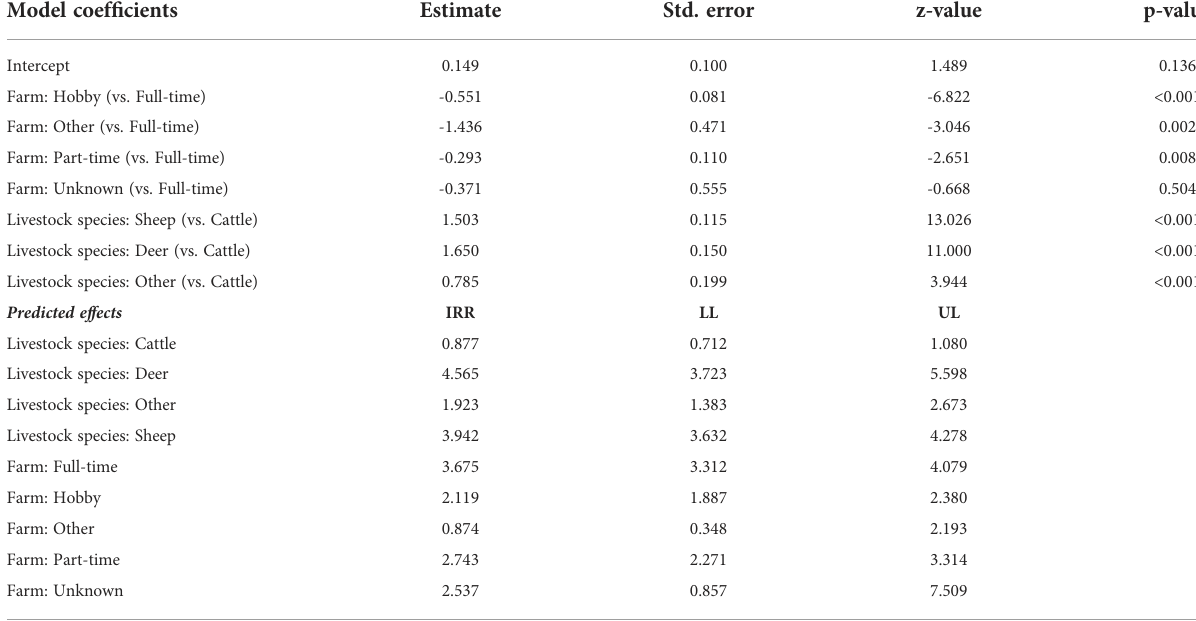
TABLE 1 Summary statistics of the negative binomial regression model to assess correlates of predation on livestock by wolves in Brandenburg State (Germany). Model coef fi